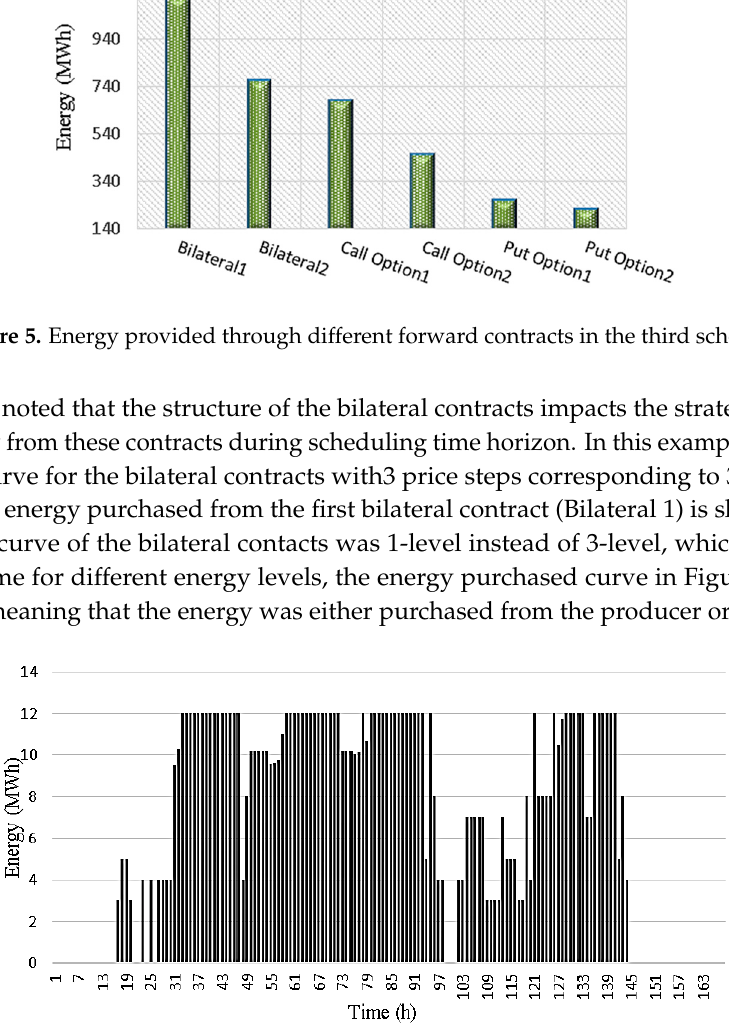
Figure 6. Energy purchased from the Bilateral 1 contract under the third scheme.